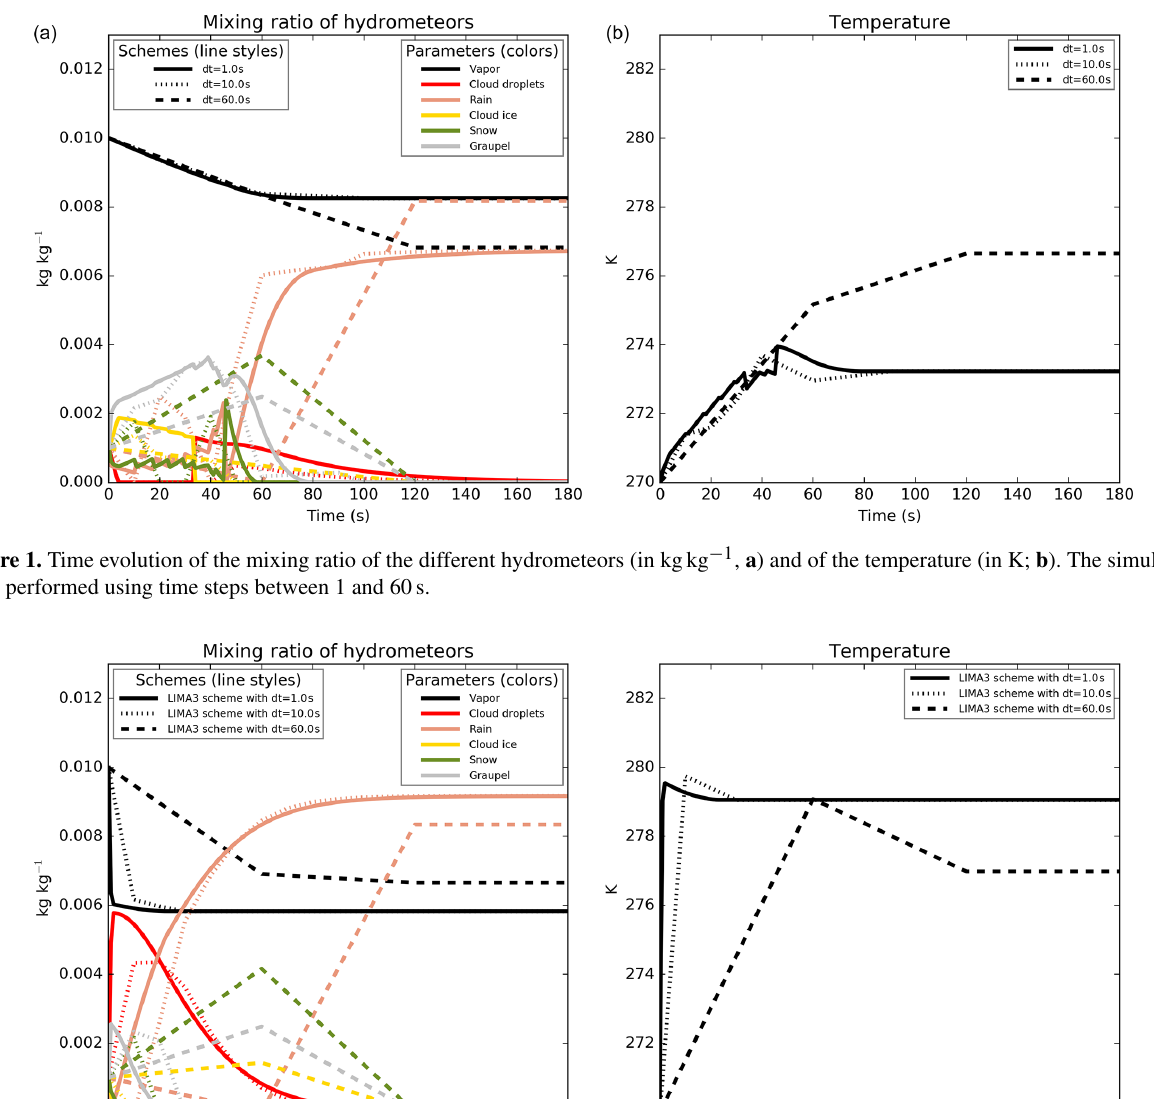
(Param1.1, Param2.1 and Param2.2 boxes) are created, one for each of the configurations (e.g., time-step length, options specific to the